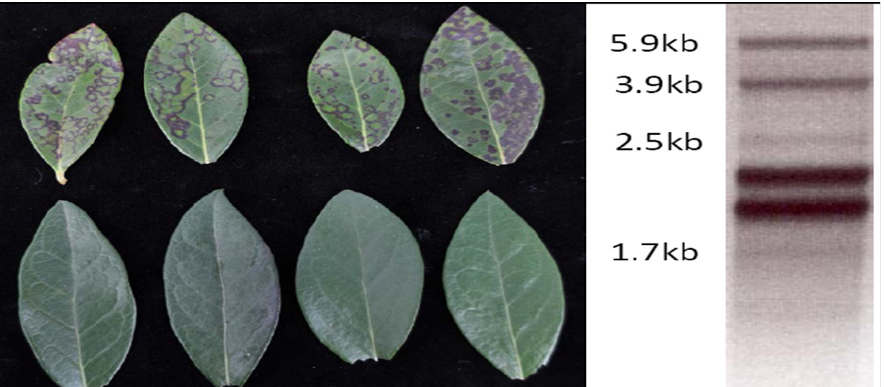
Figure 7. Blueberry necrotic ring blotch: ( A ) Virus symptoms in blueberry cultivar ‘Star’, upper row, symptomatic leaves showing range of necrotic rings and spots, lower row, healthy leaves; and ( B ) dsRNA extracted from symptomatic plants, the two bands between 1.7 kb and 2.5 kb, represent